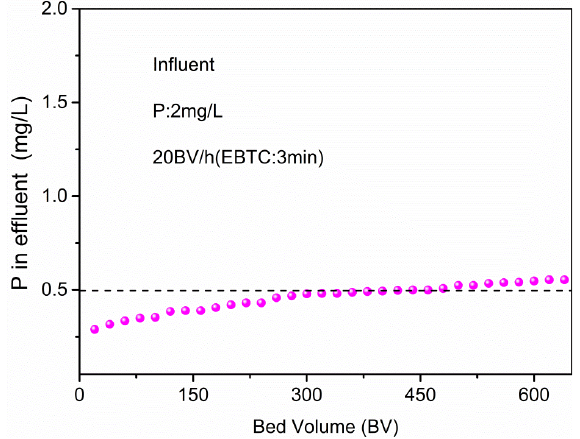
Figure 8. Breakthrough curve forphosphate adsorption by MALS-B.